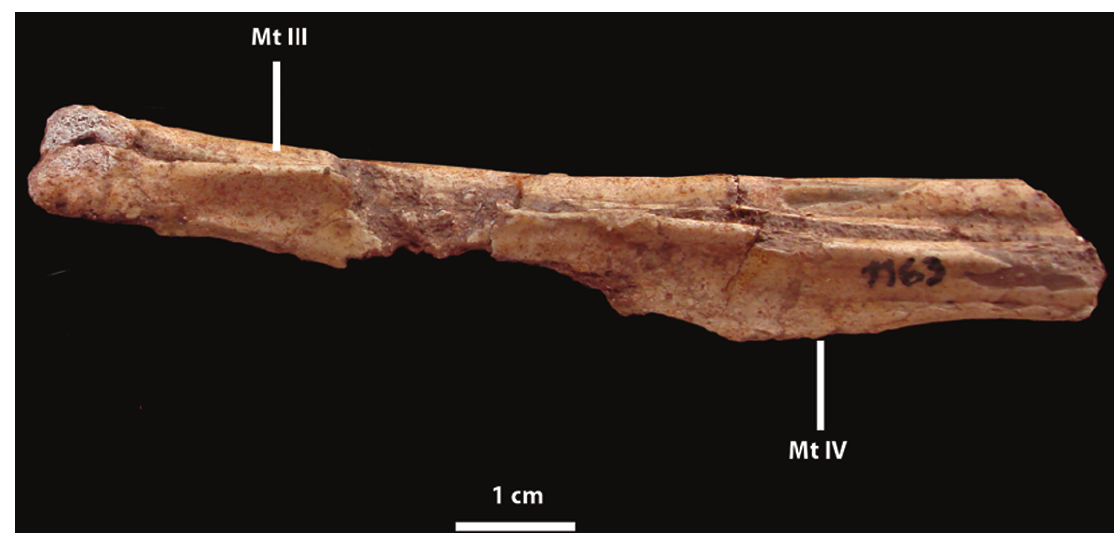
Fig. 2 – Metatarsals in lateral